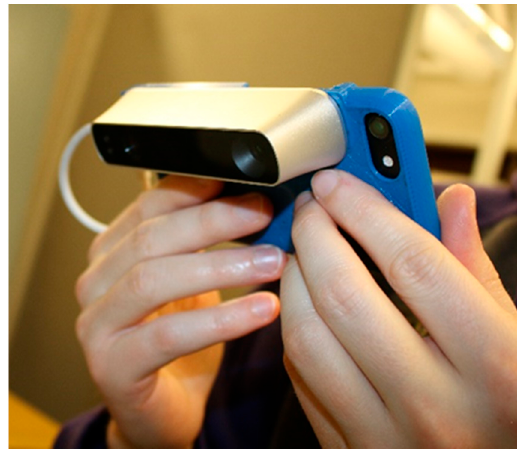
Figure 2. A user is holding an iPhone with the Structure Sensor.